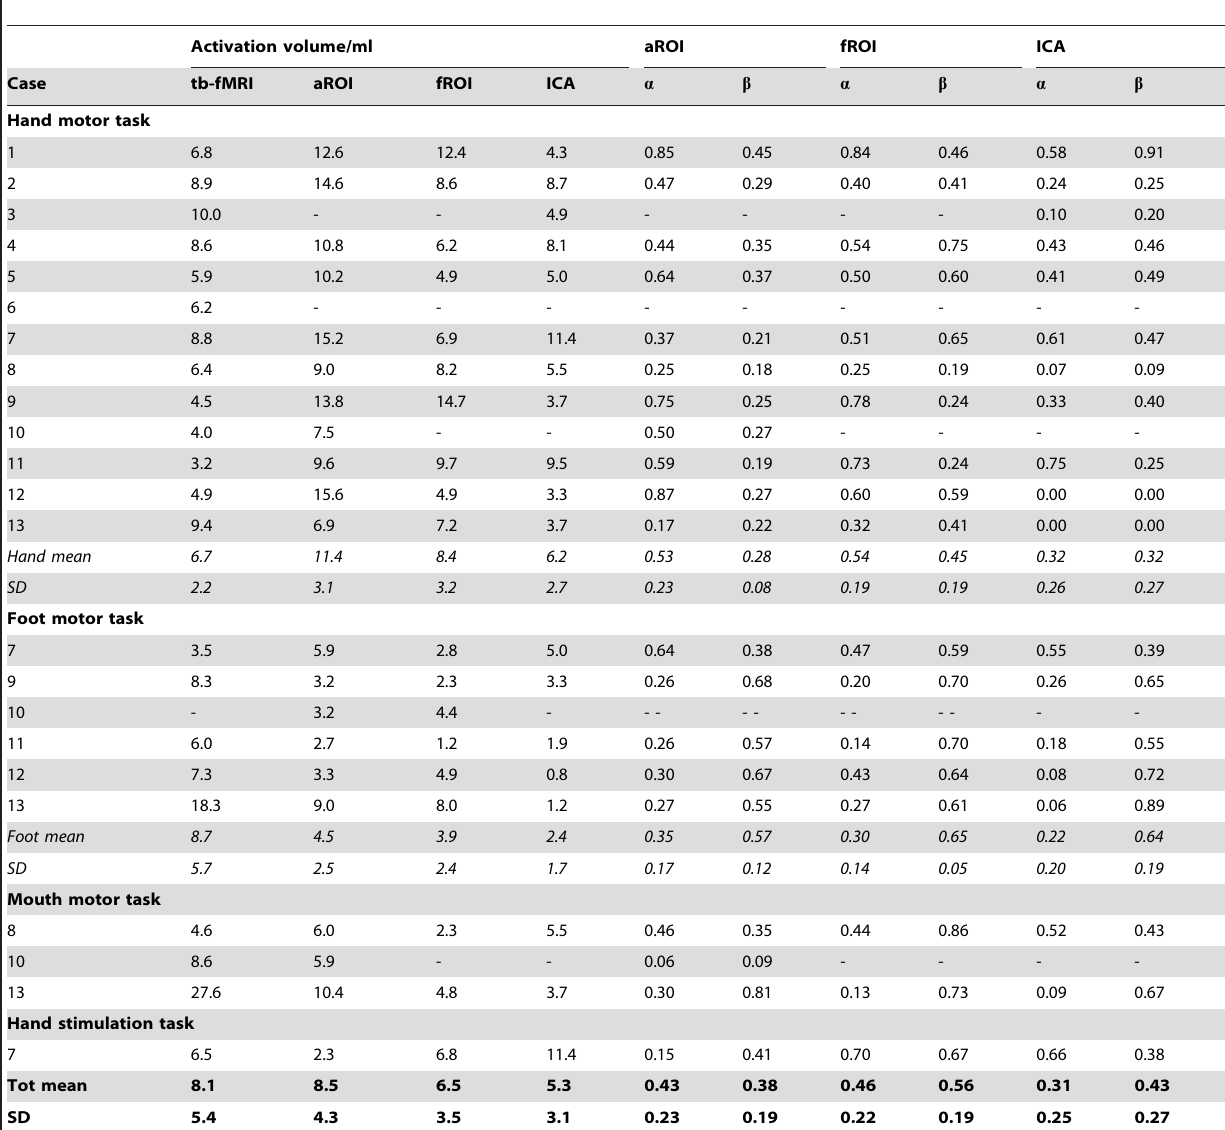
Table 5. Activation volumes (calculated over the corresponding anatomical masks), overlap sensitivity ( a ) and specificity ( b ) of resting-state fMRI (rs-fMRI) with respect to task-based fMRI (tb-fMRI), obtained with AMPLE